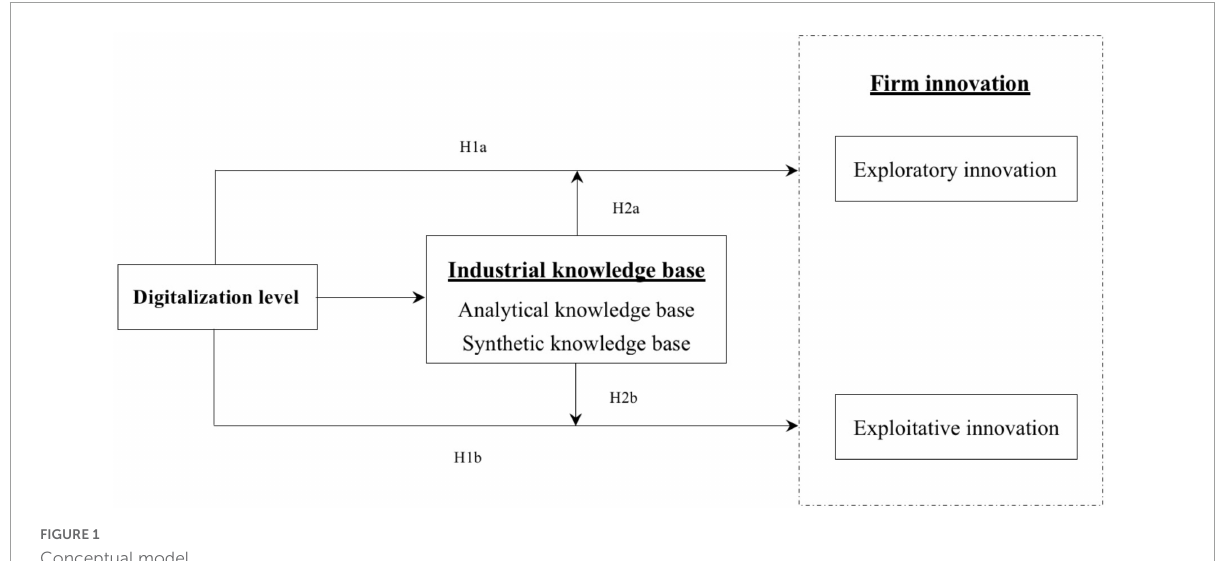
FIGURE1 Conceptual